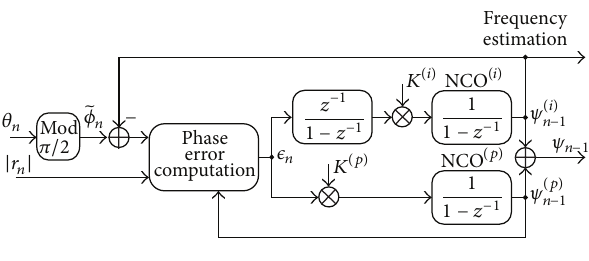
Figure 13: Modified phase domain digital PLL.